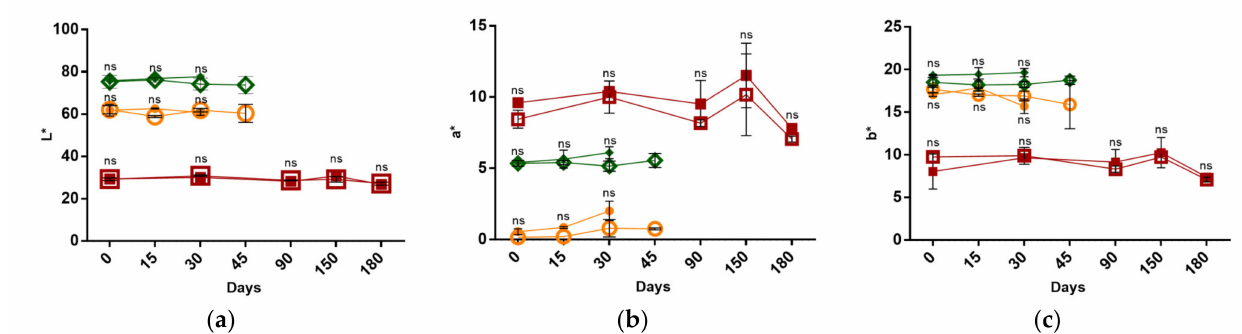
▽ Figure 1. Evaluation of total aerobic mesophiles at 30 °C of ( a ) Macroalgae-fortified meat frankfurter sausage (non-pres- ◇ — pressurized and below the detection limit ), ( b ) Macroalgae-fortified vegetable frank- surized— ● , pressurized— ○ , and ) and ( c ) Macroalgae-fortified traditional Portuguese sausage furter sausage (non-pressurized— ◆ and pressurized— Figure 3. Color of fortified foods over time in different processing conditions (non-pressurized and pressurized). ( a ) L* (pressurized and below the detection limit— □ and non-pressurized— ■ ) during storage at 4 °C. *, **, ***, **** indicate sig- (lightness) parameter, ( b ) a* (redness) parameter and ( c ) b* (yellowness) parameter of Macroalgae-fortified meat frankfurter nificant differences between each pressurized and non-pressurized sample, p < 0.1, 0.01, 0.001 and 0.0001, sausage (pressurized— and non-pressurized— • ), Macroalgae-fortified vegetable frankfurter sausage (pressurized— (cid:35) non-pressurized—